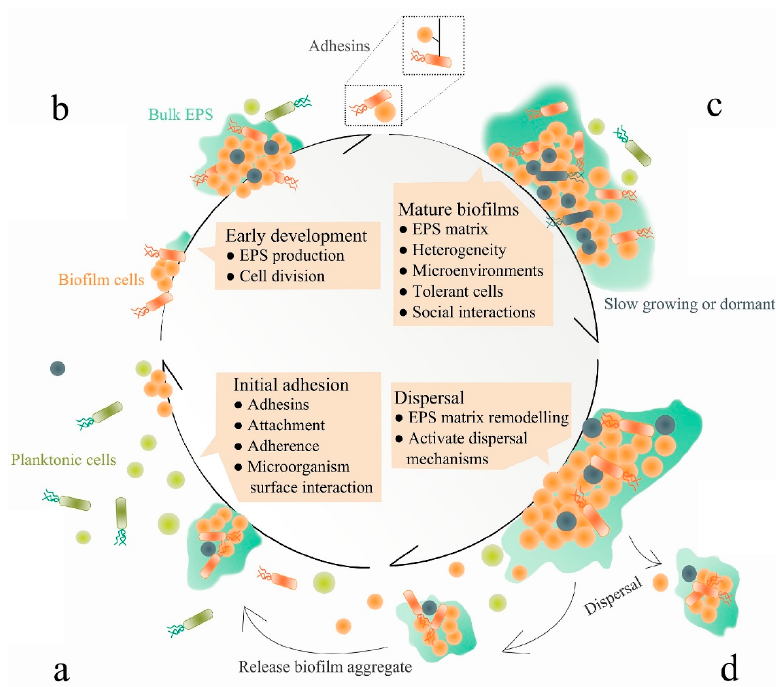
Figure 2. The molecular mechanisms of biofilm formation. Attachment ( a ), biofilm formation ( b ), maturation ( c ) and dispersion ( d ). Adapted from Jiang et al. [34]. The different colours and shapes model the different bacterial cells composing the biofilm.